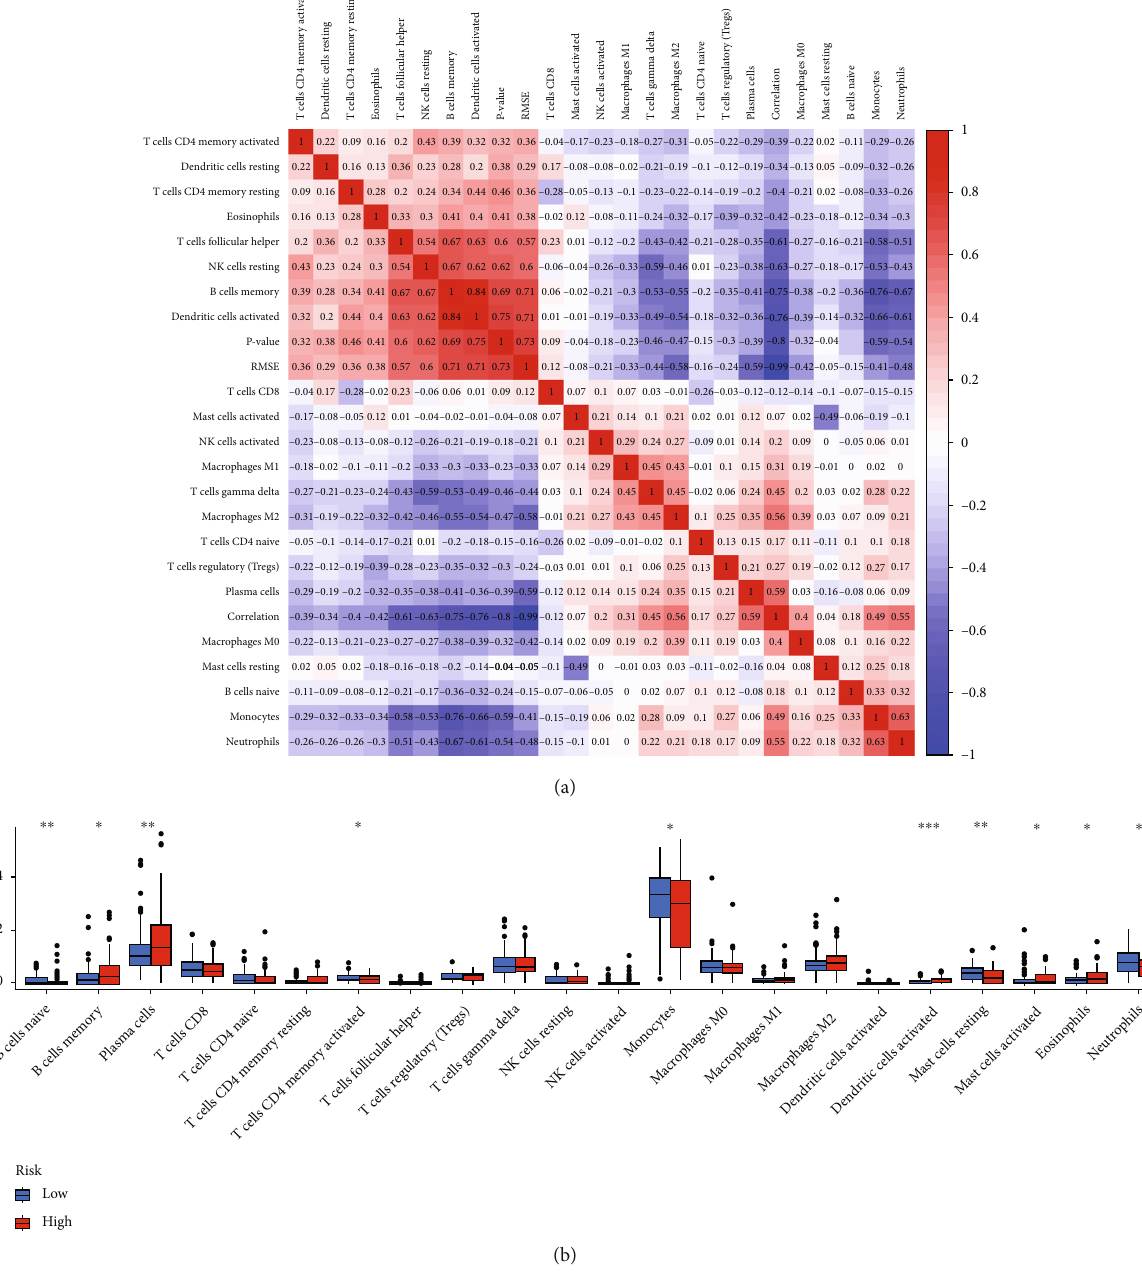
Figure 6: Correlation analysis of the tumor microenvironment and the immune cell in fi ltration in the low- and high-risk groups. (a) In fi ltration scores for each immune cell type were plotted on a heat map by means of row scaling. (b) Histogram of immune cells that have di ff erential in fi ltration. The red and blue columns indicate the low- and high-risk